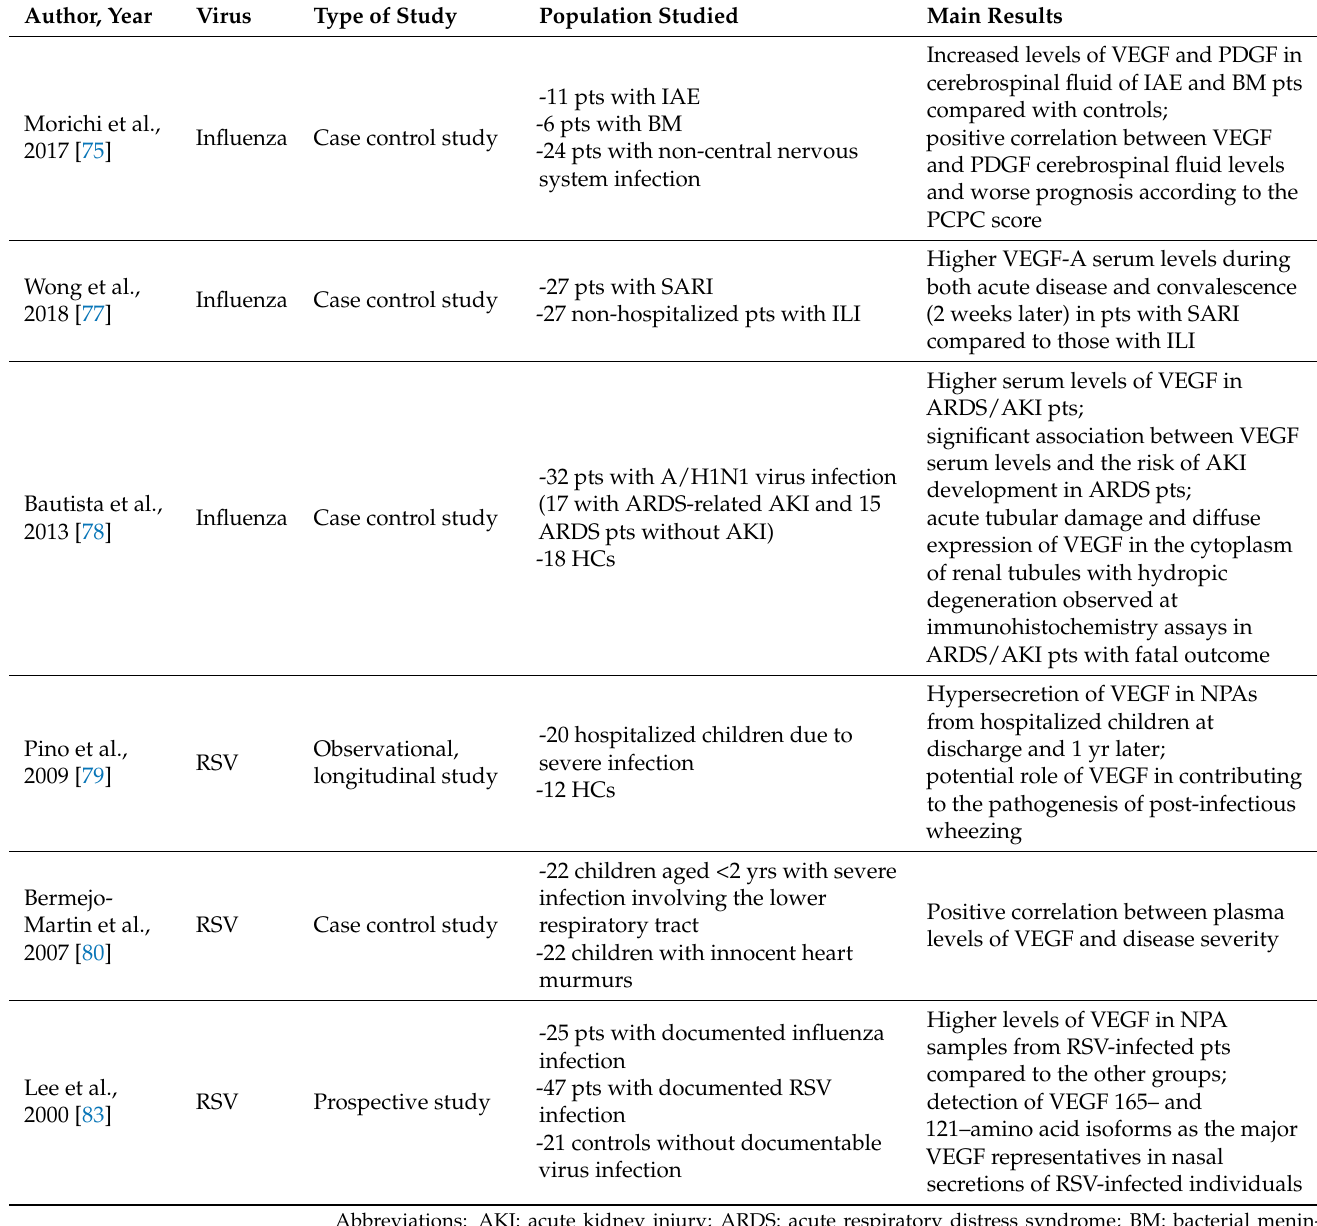
Table 1. Summary of the clinical studies linking VEGF dysregulation to human respiratory viral